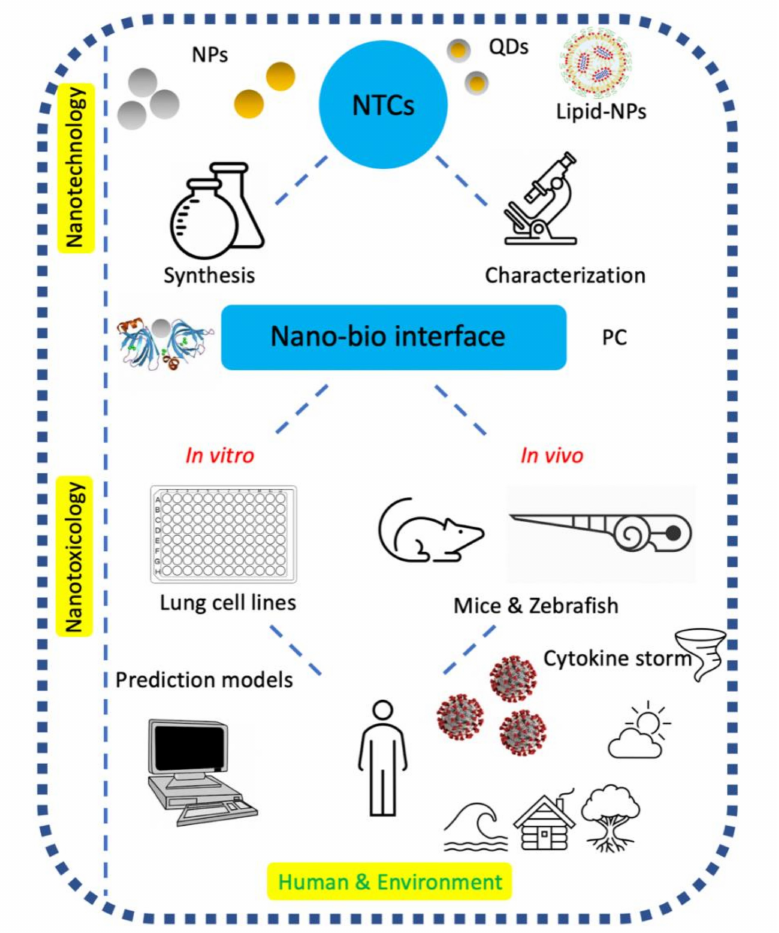
Figure 1. The nanotoxicology of anti-coronavirus nanotheranostics (NTCs) connects the pieces (i.e., the chemistry of nanomaterials, interfaces, and biology) of the scientific jigsaw puzzle played by humans in our shared environment in attempting to decipher their safety